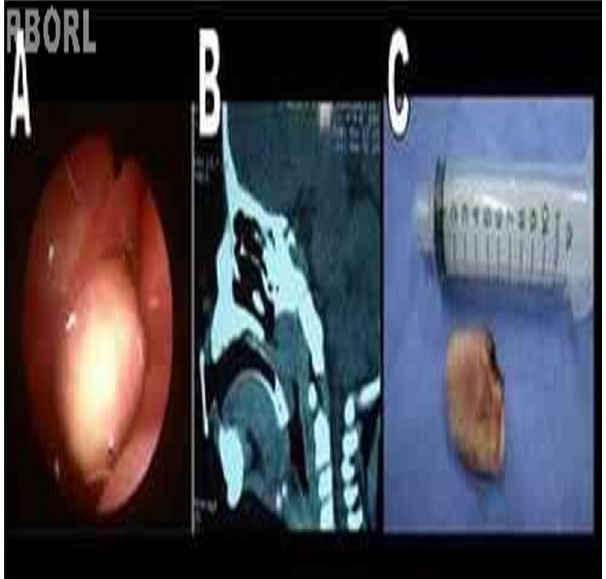
Fig. 1 (A) Tumor obstructing the rhinopharynx on the left. (B) Computed tomography showing a lesion limited to the rhinopharynx. (C) Surgical specimen. infants, which should include choanal atresia, intranasal glioma, encephalocele, rhabdomyosarcoma, dermoid cyst, lymphangioma, hemangioma, and neurofibromatosis. Imaging studies are helpful to determine the differences between solid and cystic tumors, in addition to showing the location and extent of lesions, thus aiding in the clin- ical management and the surgical approach. However, they do not differentiate benign from malignant lesions. 2,3 In the present case, computed tomography (CT) and magnetic resonance imaging (MRI) identified a mass obstructing the nasopharynx, with no signs of infiltration or continuity with intracranial